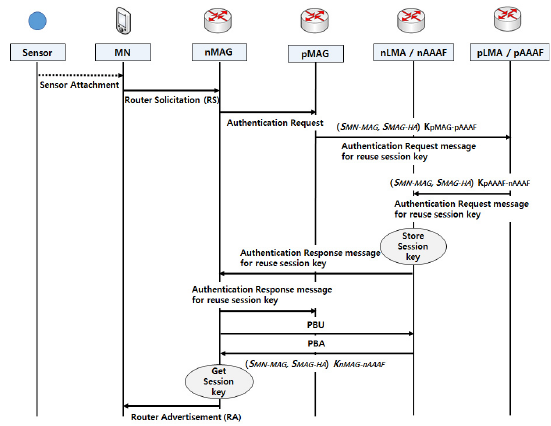
Figure 5. Inter-domain handover